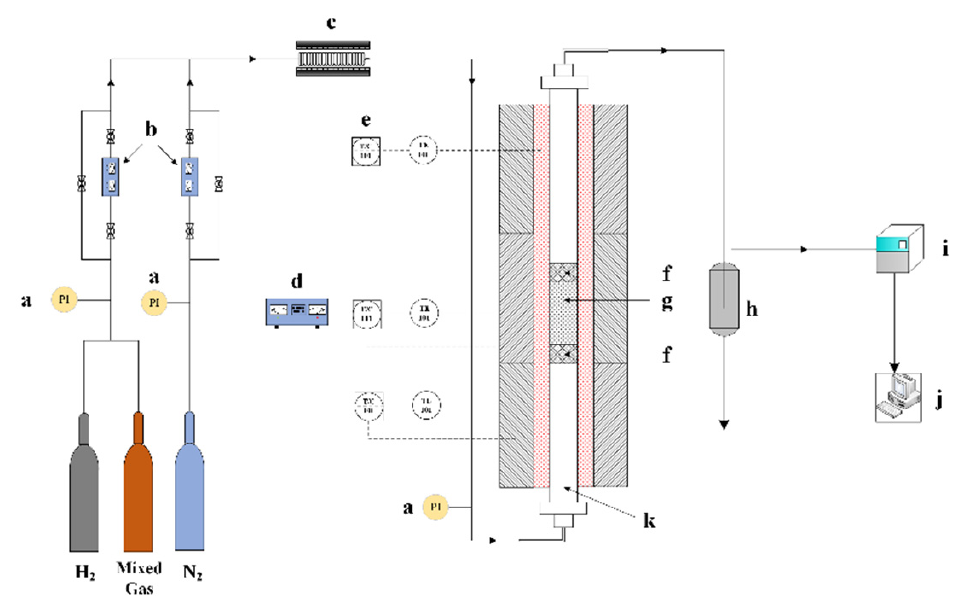
Figure 1. Schematic diagram of reactor for carbon dioxide hydrogenation to prepare light olefins: ( a ) pressure gauge; ( b ) mass flowmeter; ( c ) preheater; ( d ) temperature controller; ( e ) thermocouple and temperature display; ( f ) silica wool; ( g ) catalyst; ( h ) gas–liquid separator; ( i ) gas chromatograph; ( j ) computer; ( k ) fixed-bed reactor.